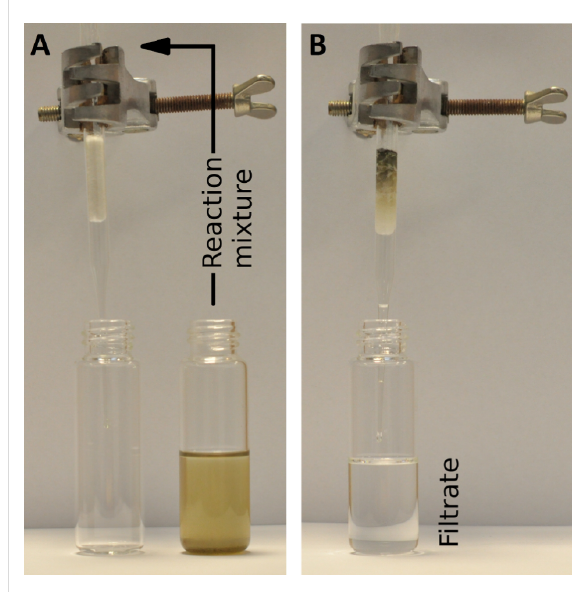
Figure 6: Filtration of the reaction mixture after RCM of 9 catalysed by 1 mol % of 8